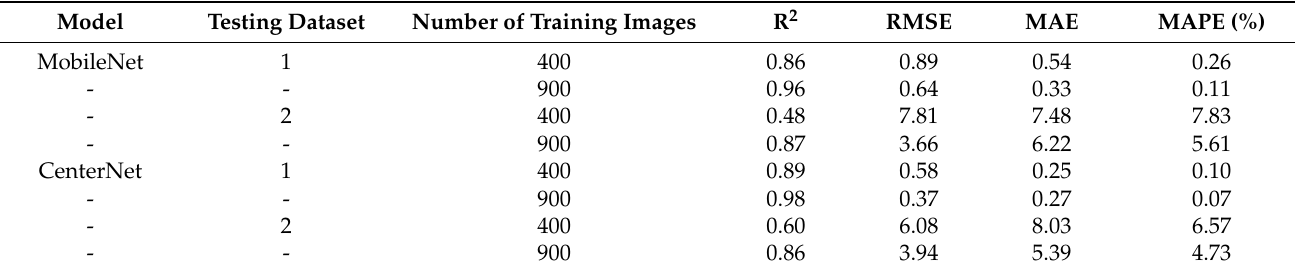
Table 2. Coefficient of determination (R 2 ), root mean square error (RMSE), mean absolute error (MAE), and mean absolute percentage error (MAPE) for cotton stand counting with the MobileNet and CenterNet models using unmanned aerial system